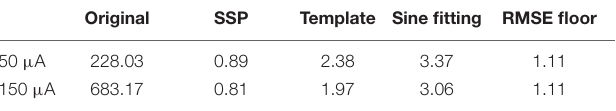
TABLE 1 | Comparison of the original and the cleaned datasets with the baseline data in terms of the root-mean-square error (RMSE). Root-mean-square error (RMSE) with respect to the baseline data [ µ V]